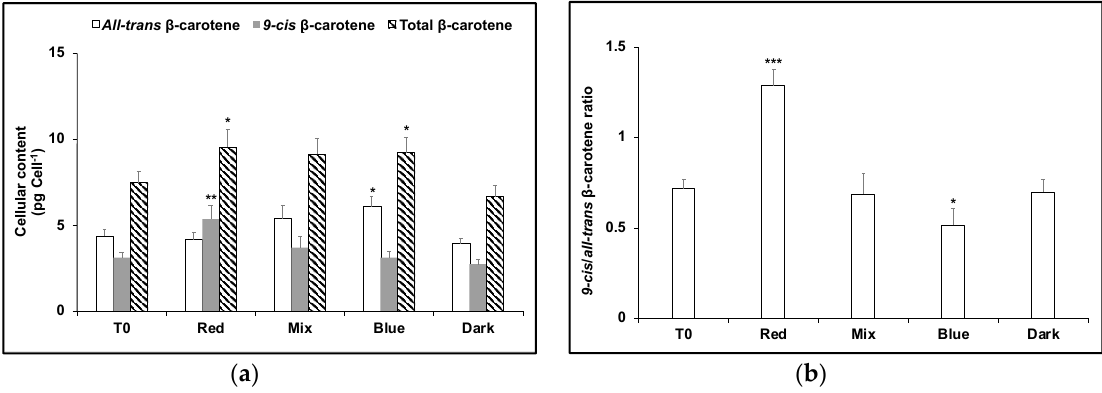
Figure 3. ( a ) Cellular content of 9-cis β C and all-trans β C and ( b ) 9-cis / all-trans β C ratio in D. salina cultures exposed to continuous blue LED light at 1000 µmol m − 2 s − 1 for 24 h followed by 24 h under either red light, a mix of 1:1 red and blue light, blue light at the same light intensity of 1000 µmol m − 2 s − 1 or dark. Each culture condition was set up at least in triplicate. Results were analysed by one way ANOVA with posterior Dunnett’s test compared to T0 and Tukey multiple pairwise-comparisons. Asterisks represent different levels of significance (*** 0 < p ≤ 0.001, ** 0.001 < p ≤ 0.01, * 0.01 < p ≤ 0.05). Since red light increased the net content of 9-cis β C, the effects of red light/dark cycles of increasing red light duration during cultivation were tested. Increasing red light duration increased the total amount of β -carotene, in particular the amount of 9-cis β C (Figure 4). With a red light/dark cycle of 10 min/110 min, the ratio of 9-cis/all-trans β C was 1.1, but in a red light/dark cycle of 30 min/30 min, this increased to 2.2, similar to that in continuous red (2.3). However, in continuous red light, the total pool size β -carotene was nearly 25% greater.